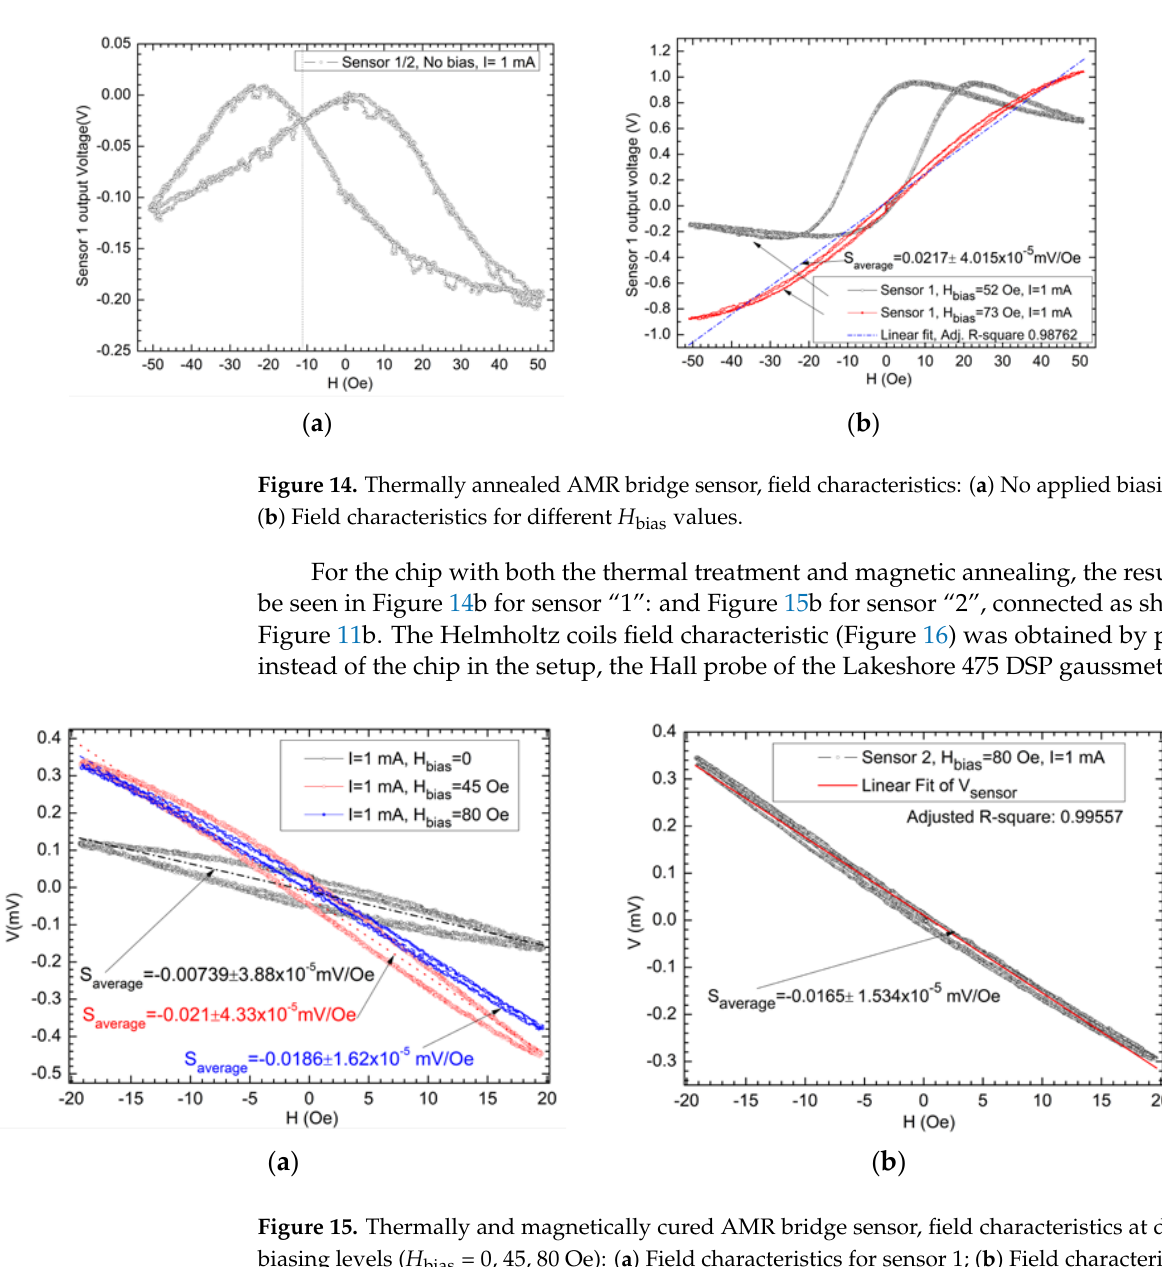
Figure 14. Thermally annealed AMR bridge sensor, field characteristics: ( a ) No applied biasing field; ( b ) Field characteristics for different H bias values.